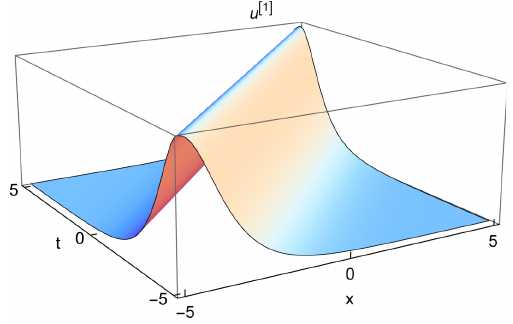
Figure 1. u [ 1 ] for parameters θ 0 = 0, λ 1 =